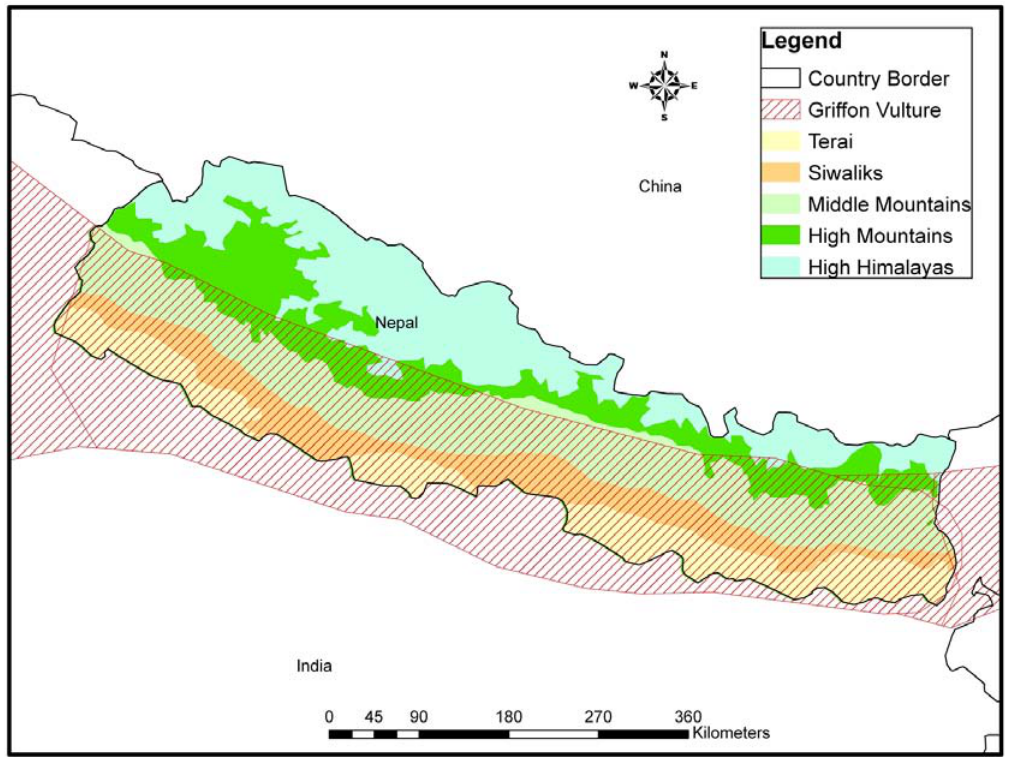
Figure 6. Griffon Vulture distribution in Nepal. Adapted from (Birdlife International & NatureServe